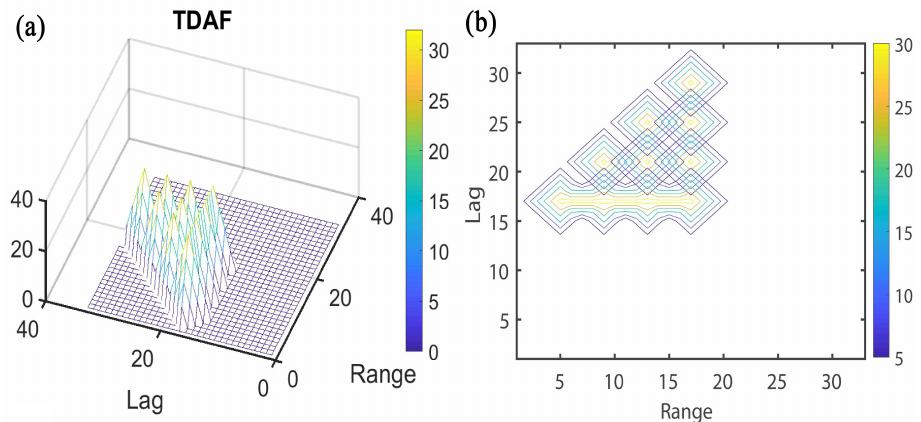
Figure 6. ( a ) TDAF of 4-bit strong alternating code and ( b ) corresponding contour